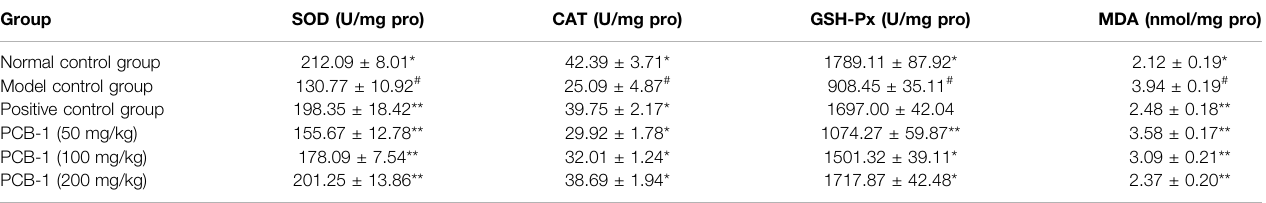
TABLE 2 | Effects of PCB-1 on activities of SOD, CAT, GSH-Px and levels of MDA in liver of D-gal induces oxidative damage mice.